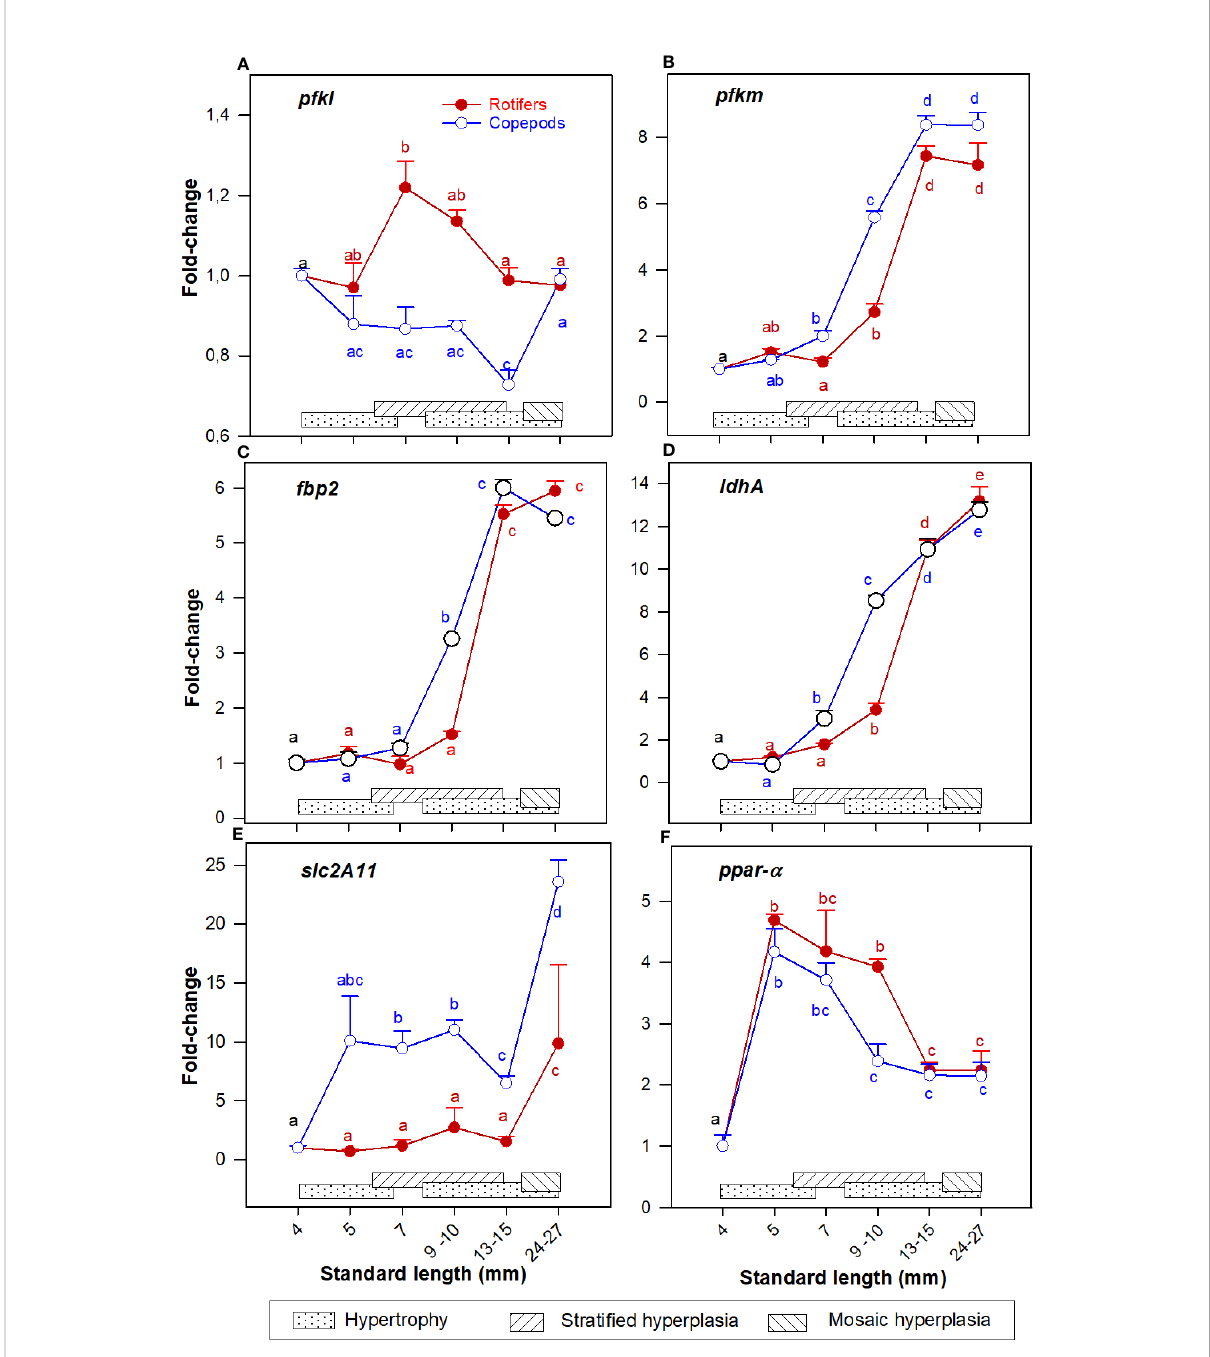
FIGURE 4 Gene expression (RNA-seq) of (A) pfkl ; (B) pfkm ; (C) fbp2 ; (D) ldhA ; (E) slc2a11 ; and (F) ppar-a in whole-body Atlantic cod larvae fed rotifers/ Artemia (red line) or Copepods (blue line) in relation to muscle growth dynamics: Muscle growth dynamics (hypertrophy and strati fi ed and mosaic hyperplasia) in relation to body size are indicated by horizontal bars (data from Vo et al., 2016). Data are given as mean (n=3 [n= 4 at 4 dph] ± SEM) and values are expressed as fold change compared to day 4 post-hatch. Different letters indicate signi fi cant differences between the larval stages and treatments (P <